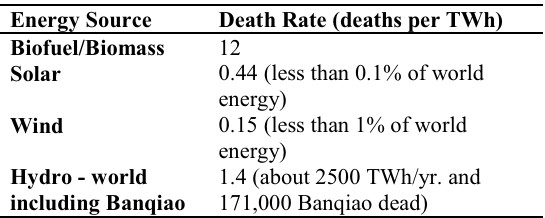
Table 1: Accident fatalities per energy produced by fuel chain